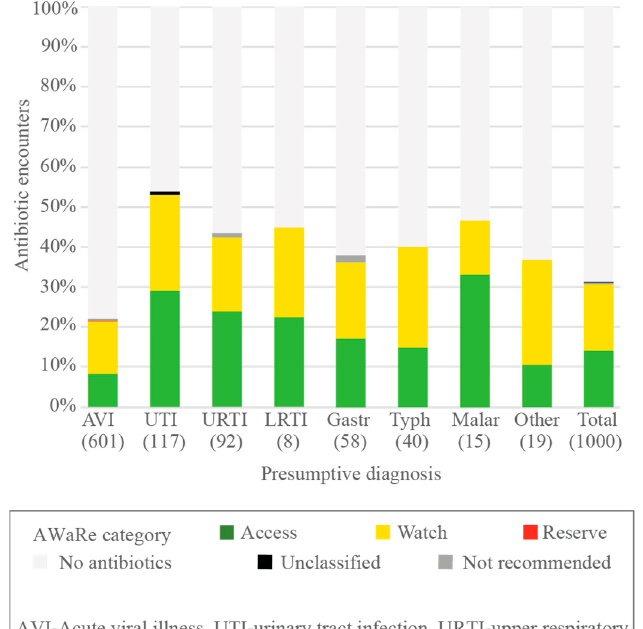
Figure 3. Distribution of antibiotic prescription during the outpatient visit by presumptive diagnosis for all patients and AWaRe category in encounters. Acute viral illness accounted for almost half of the total DDDs (642.1/1425.3, 45.0%),